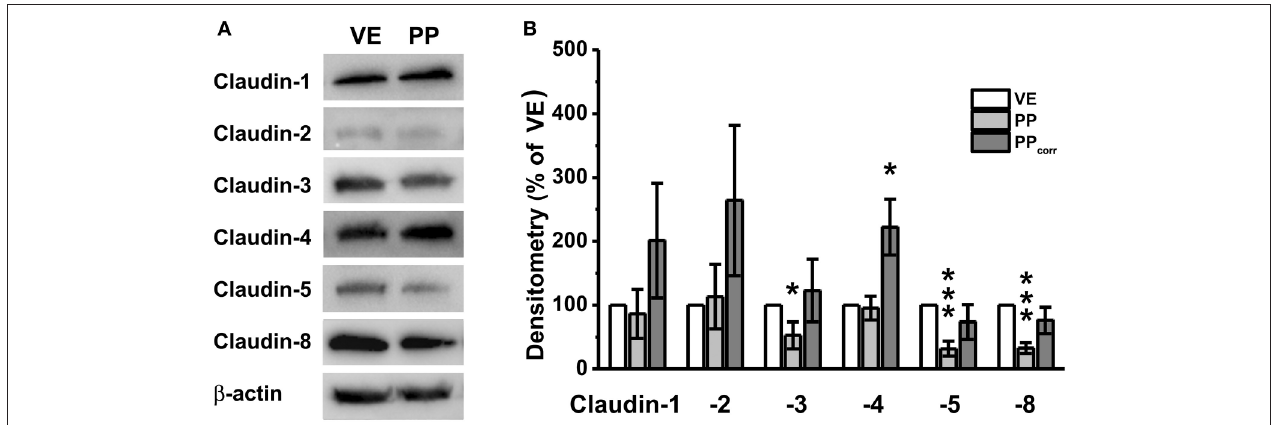
FIGURE 3 | (A) Immunoblots, (B) Densitometry. (A) In both, Peyer’s patch (PP) and neighboring villous epithelium (VE), claudin-1, claudin-2, claudin-3, claudin-4, claudin-5, and claudin-8, were detected. (B) Densitometric analysis of tight junction protein signals revealed significantly stronger claudin-4 expression in PP after surface correction ( n = 5, * p < 0.05, *** p < 0.001).